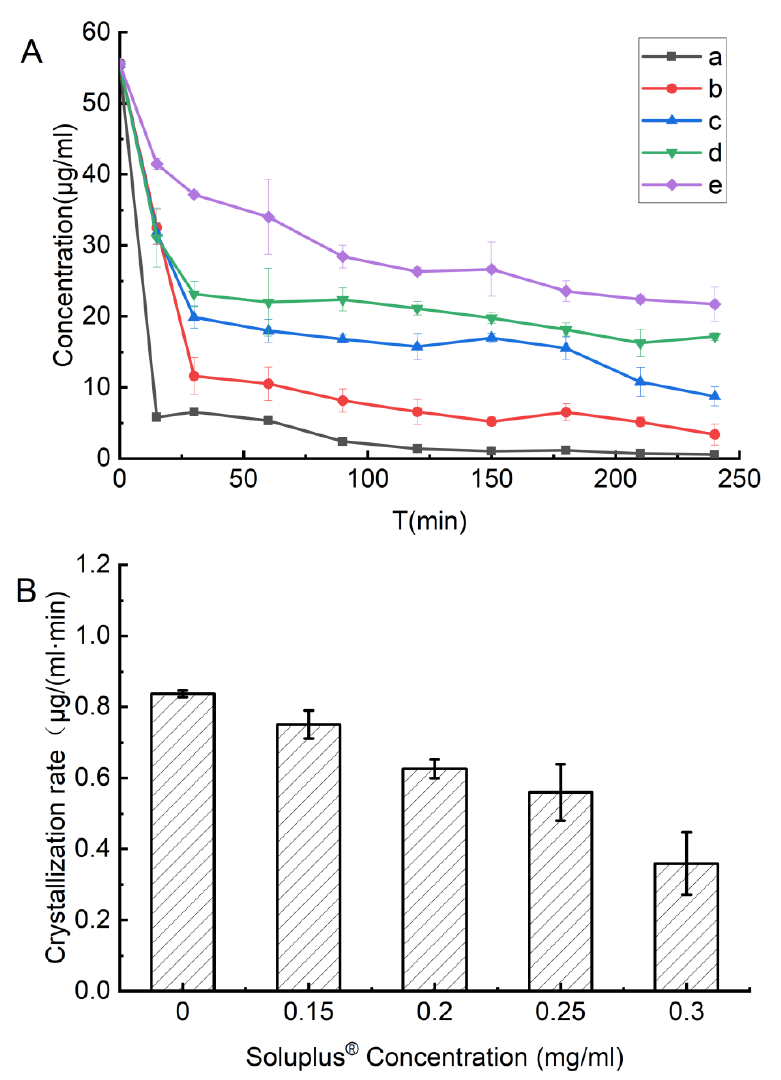
Figure 9. ( A ) Inhibition effects of Soluplus ® on the recrystallization of FEL from a supersaturated concentrated solution (55.56 μg/mL) at 37 °C in the PBS (pH 6.8) (a) and mixed with Soluplus ® of different concentration of 0.15 (b), 0.2 (c), 0.25 (d), or 0.3 mg/mL (e). ( B ) FEL crystallization rate at different Soluplus ® concentrations. Standard deviation expressed by error bars (n = 3).